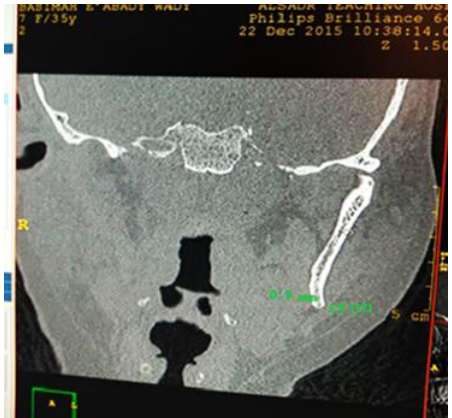
Fig 4:Radiographic image of CT scan (coronal